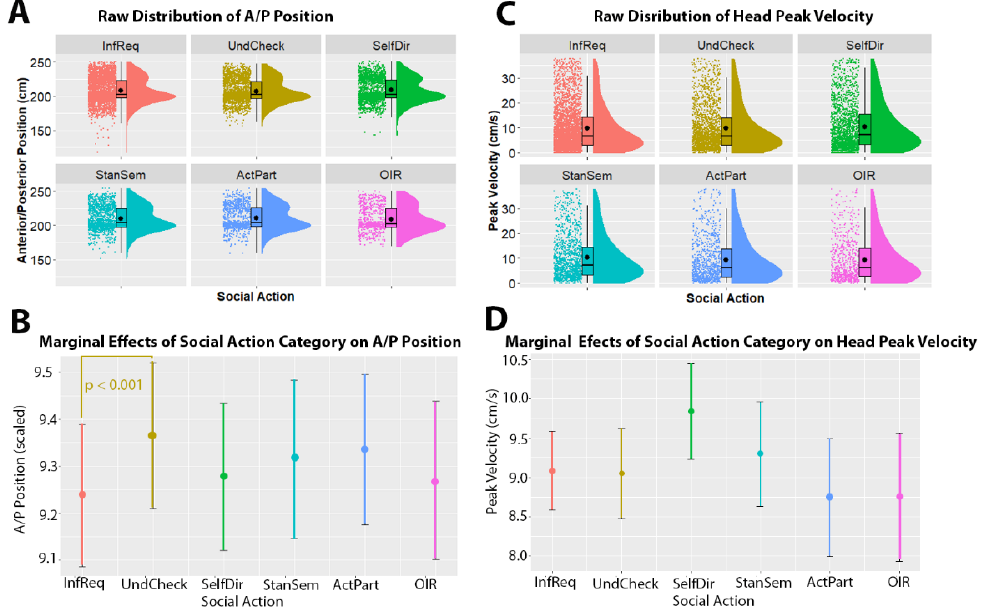
Figure 3. Relationship between head movement and social action category. Panels ( A , C ) show raincloud plots of the raw distribution of kinematic values ( y -axis) across each of the social action categories ( x -axis). The raincloud plots show the overall density of the distribution (shaded curve), the boxplots show the median and interquartile range, while the black dots show the individual data points. Panels ( B , D ) depict the marginal effects of the mixed model (i.e., the predicted values when holding other model terms, such as utterance duration and per-participant intercepts, constant). In panels ( B , D ), social action categories are given on the x -axis, and kinematic values are given on the y -axis (note that anterior/posterior position is scaled to range = 0.1–12.7) is given on the y -axis. Note that in this model, there were no significant contrasts between social action categories. Abbreviations: InfReq = Information Request; UndCheck = Understanding Check; SelfDir = Self-Directed Question; OIR = Other-Initiated-Repair; StanSem = Stance or Sentiment; ActPart = Active Participa- tion.